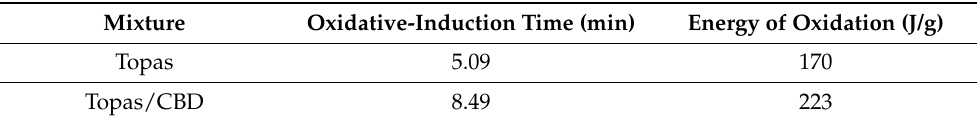
Table 3. Oxidative-induction time (OIT) values of ethylene-norbornene copolymer (Topas)-based samples before aging and their energy of